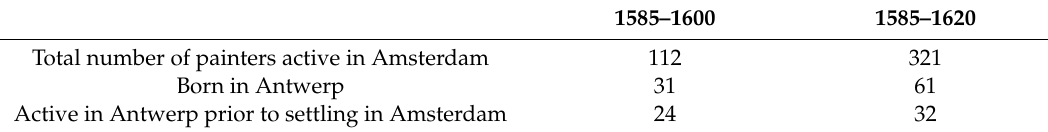
Table 1. Painters in Amsterdam and their relation to Antwerp, 1585–1600 and 1585–1620.